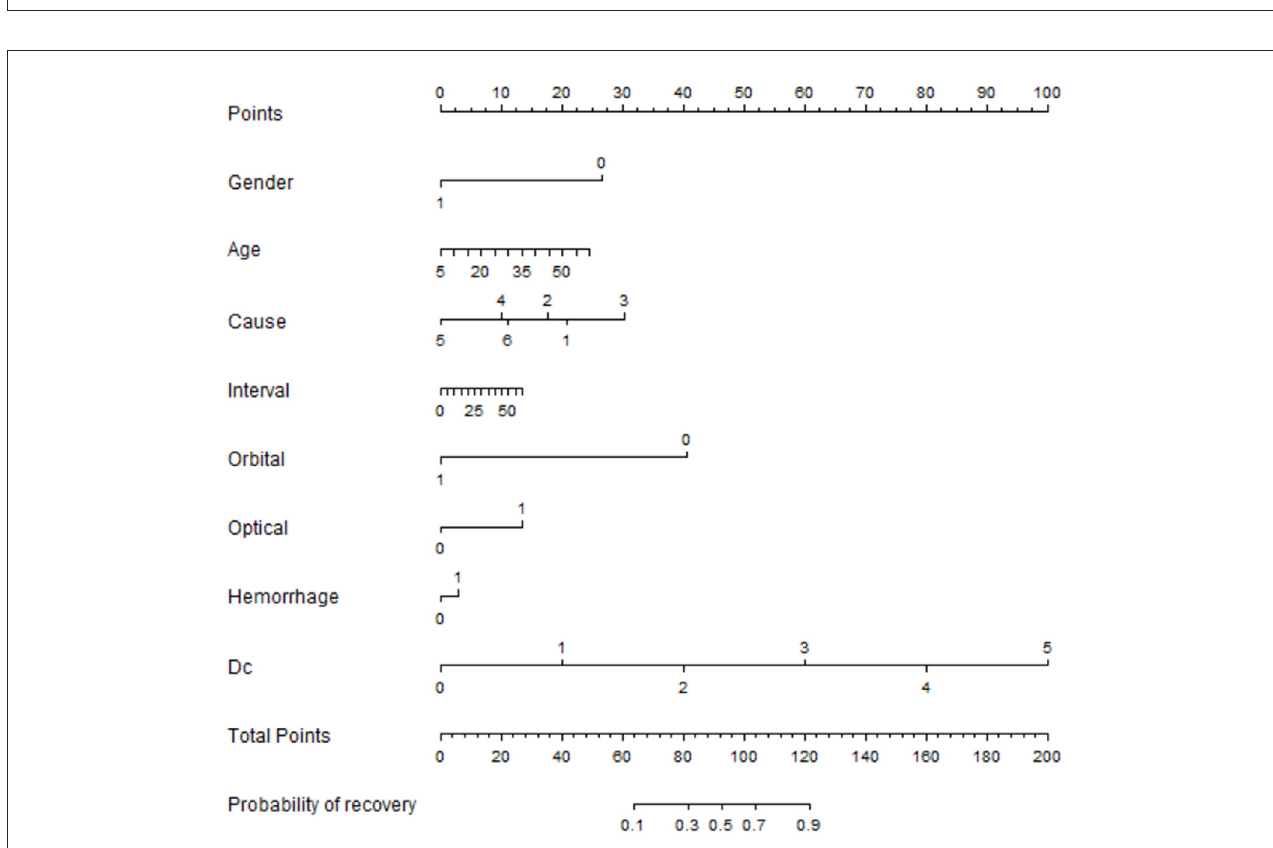
FIGURE7 Prediction model nomogram: A score of 95 predicted that the probability of postoperative improvement was 50%. Dc: times of dressing change.